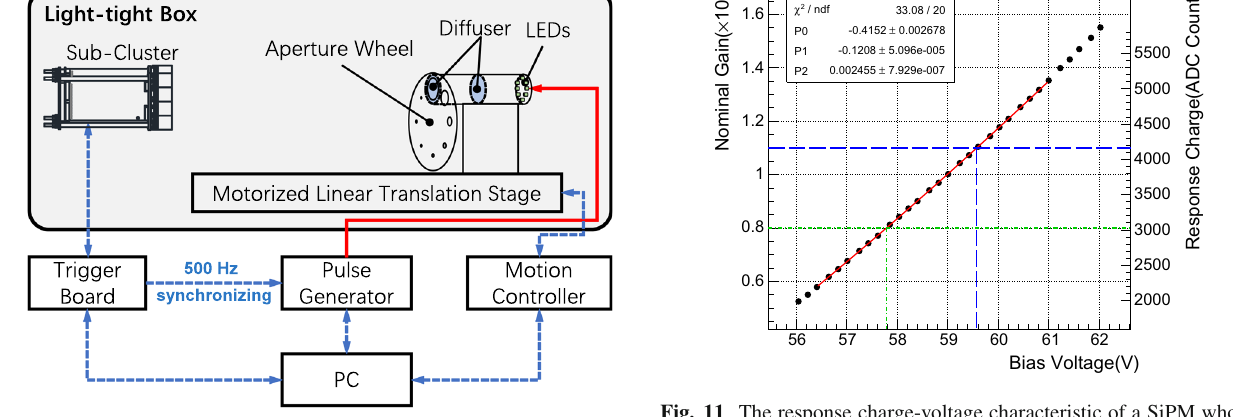
Fig. 11 The response charge-voltage characteristic of a SiPM whose serial number is 7517. The SiPM temperature is 20 ◦ C. The response charge is read from the high gain electronic channel. The red line is a quadratic fitting. The blue dashed line indicates the bias voltage for g = 1 . 1 × 10 6 , while the green dash-dotted line indicates the bias voltage for the nominal gain g = 8 × 10 5